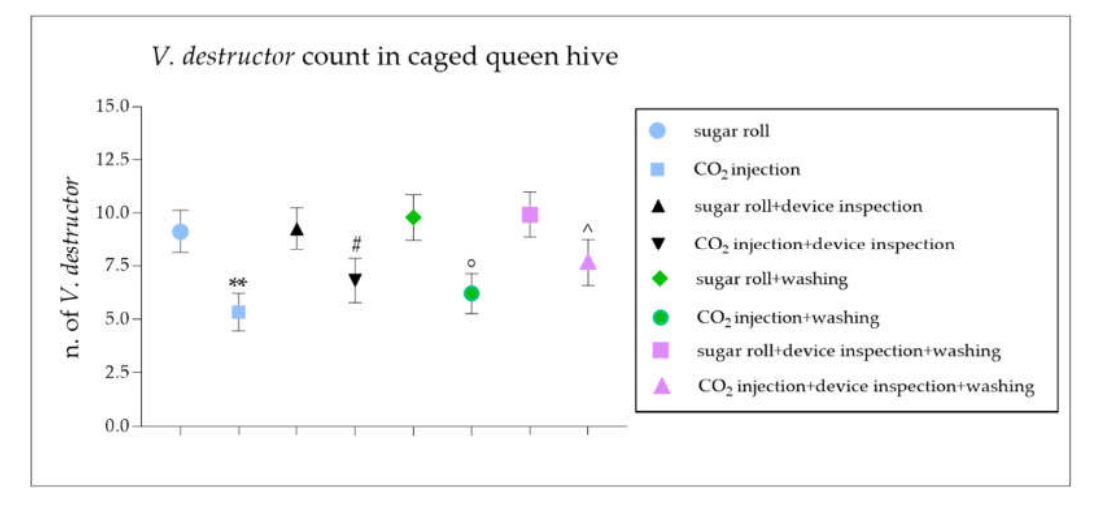
Figure 4. Comparison between the number of dispersal V. destructor in colonies of Apis mellifera ligustica tested using standard techniques (sugar roll or CO 2 injection) and modified field techniques (sugar roll and device inspection or CO 2 injection and device inspection). The graph shows V. destructor count performed with sugar roll or CO 2 injection techniques, with or without a device inspection, in caged queen hive samples. Additionally, V. destructor counts derived from sugar roll or CO 2 injection techniques, with or without a device inspection and/or a water washing were performed. The data are presented as mean ± SEM. ** p < 0.01 vs. sugar roll and # p < 0.05 vs. sugar roll and device inspection, ° p < 0.05 vs. sugar roll and washing and ^ p < 0.05 vs. sugar roll and device inspection and washing; Mann–Whitney test ( n = 300). Data are from 15 different independent counts.